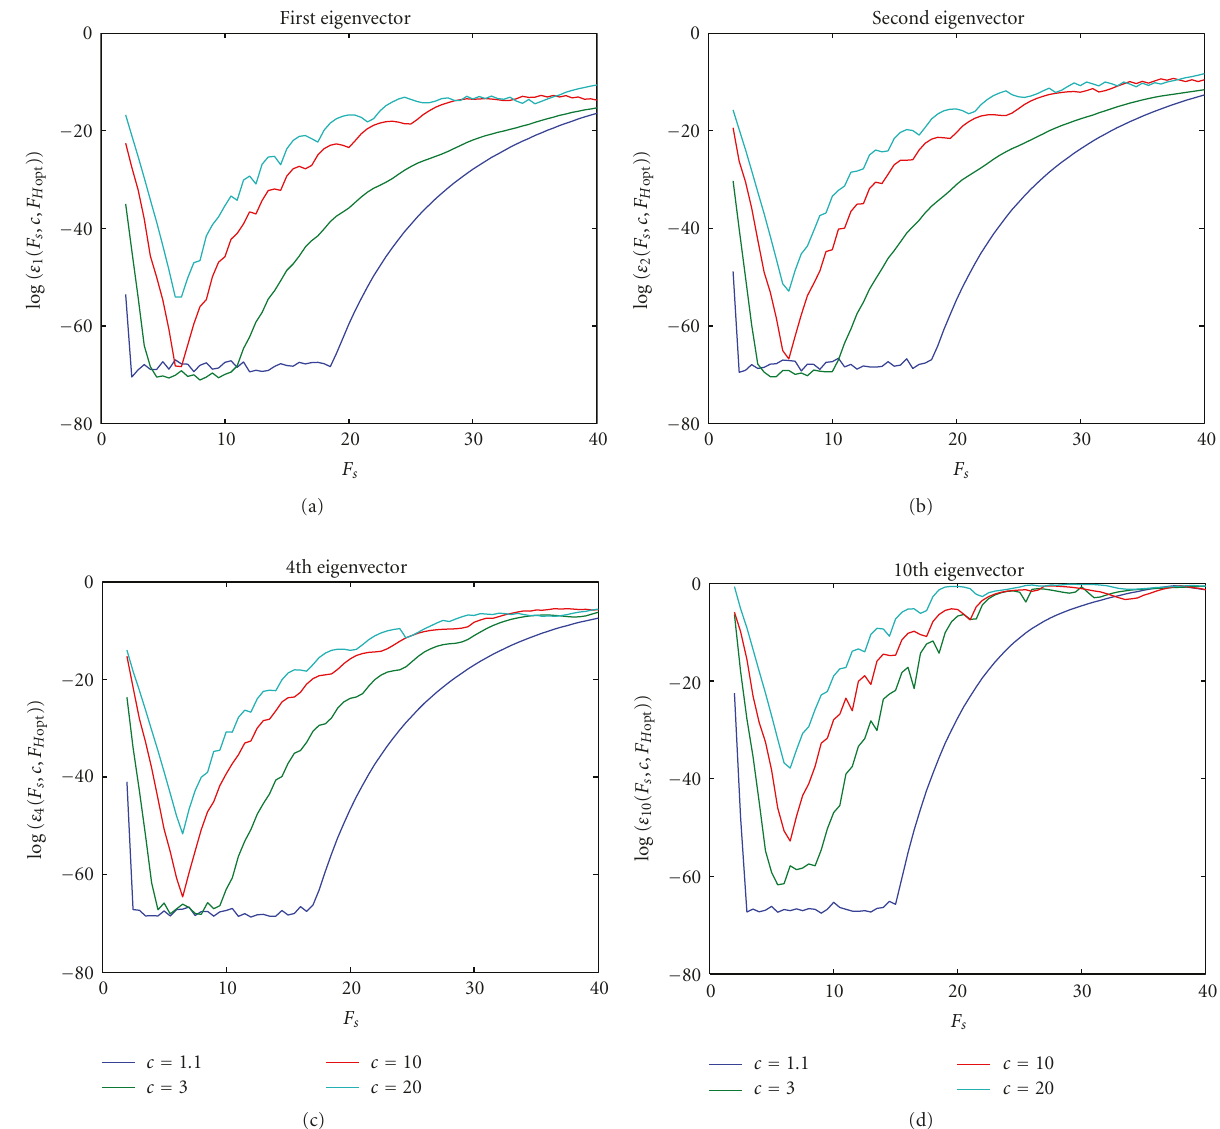
Figure 5: The dependence on F s of the errors between the eigenvector optimal to LSP and the corresponding hermite function for di ff erent c -values. The 1st, 2nd, 4th, and 10th eigenvectors are compared. The eigenvector length is N =